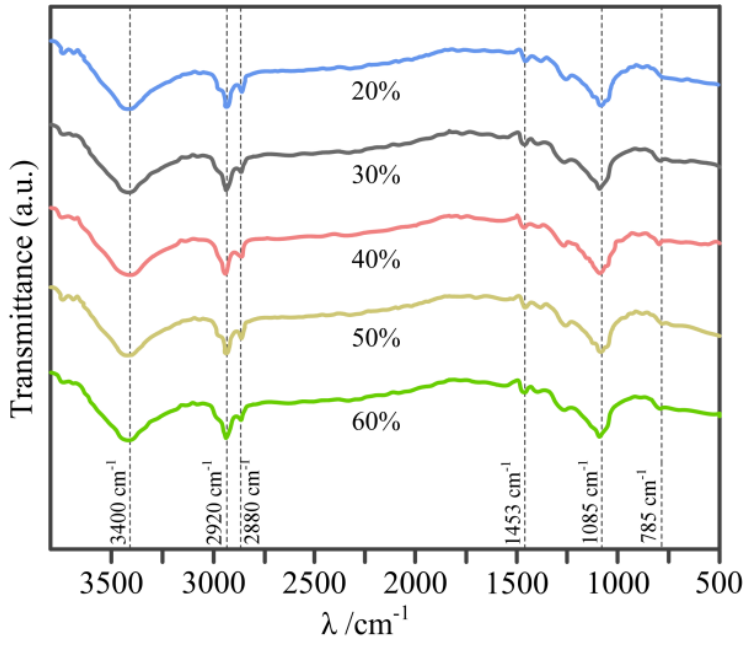
Figure 5. FTIR spectra of C WCMs with different resin concentration sintering at 800 °C.